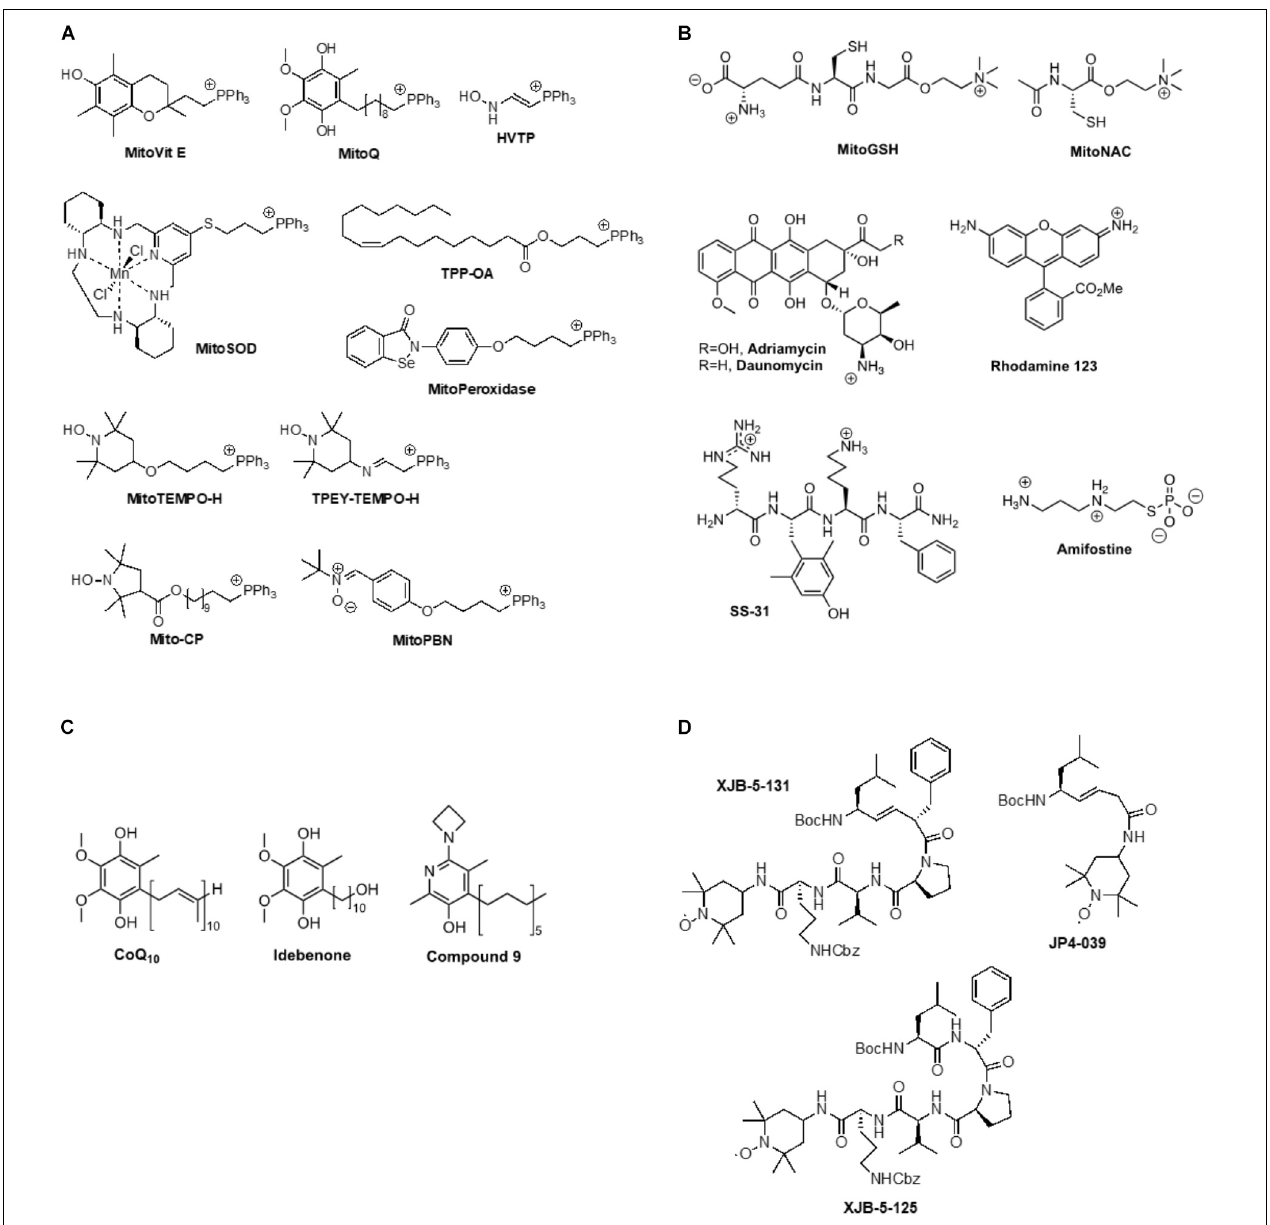
FIGURE 2 | (A) Example for triphenylphosphonium-mediated transfer of antioxidants to mitochondria, (B) Ammonium cation-mediated transfer of antioxidants to mitochondria, (C) Lipophilic phenols, (D) Mitochondrially targeted nitroxides based on a gramicidin S peptide isostere